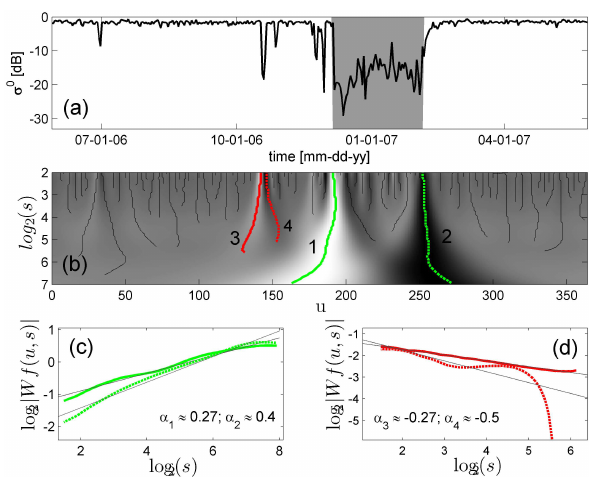
Fig. 1. (a) QuikSCAT σ 0 time series with the melt duration (MD) estimated using the CWT method shaded in grey. (b) The CWT of the time series in Fig. 1a, where dark-grey to black values indicate positive Wσ 0 and light-grey to white values negative Wσ 0 . WT- MMLs are indicated as black, green or red lines associated with melt onset (MO, WTMML 1) melt refreeze (MF, WTMML 2) and sporadic, early season melt (WTMML 3, WTMML 4). (c) The Wσ 0 along WTMML plotted over all scales, ( s ), and the associated α for the MO and MF events. (d) Same as Fig. 1c but for an early season sporadic